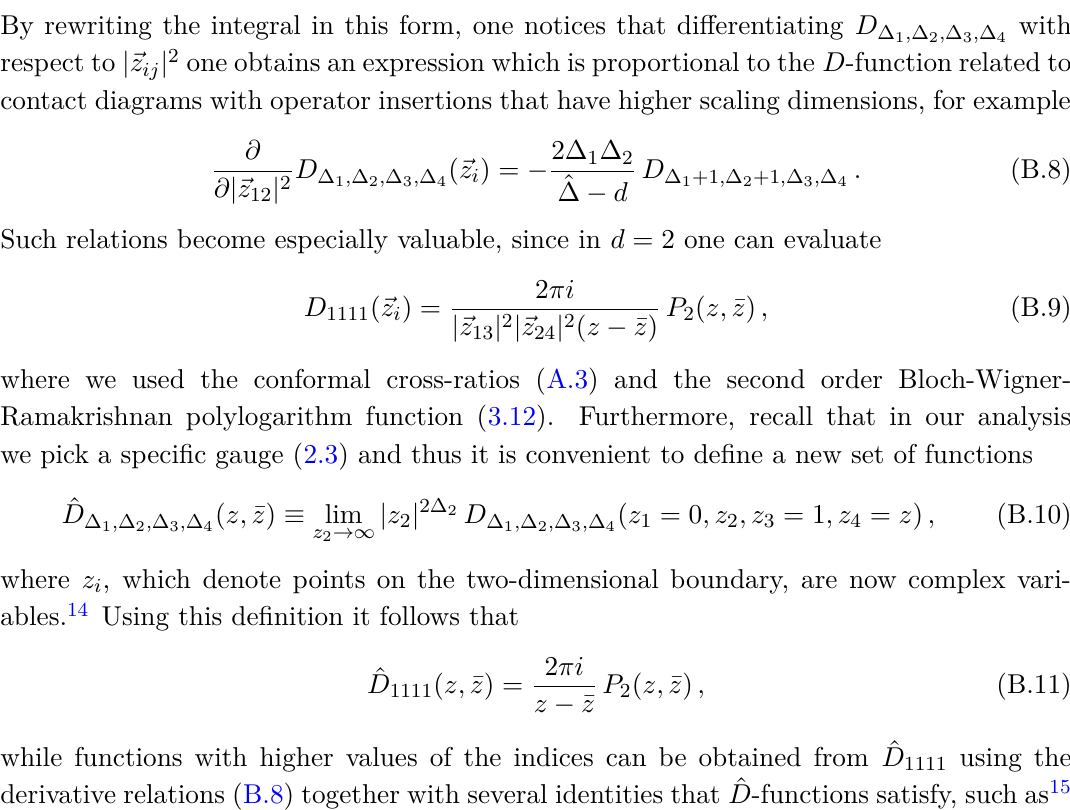
Figure 3 . The contact Witten diagram corresponding to the integral (B.3). Four scalar operator insertions O ∆ with scaling dimensions ∆ i interact via a quartic vertex in the bulk. In the expression i for D ∆ one has to integrate over all possible interaction points w 1 , ∆ 2 , ∆ 3 , ∆ 4